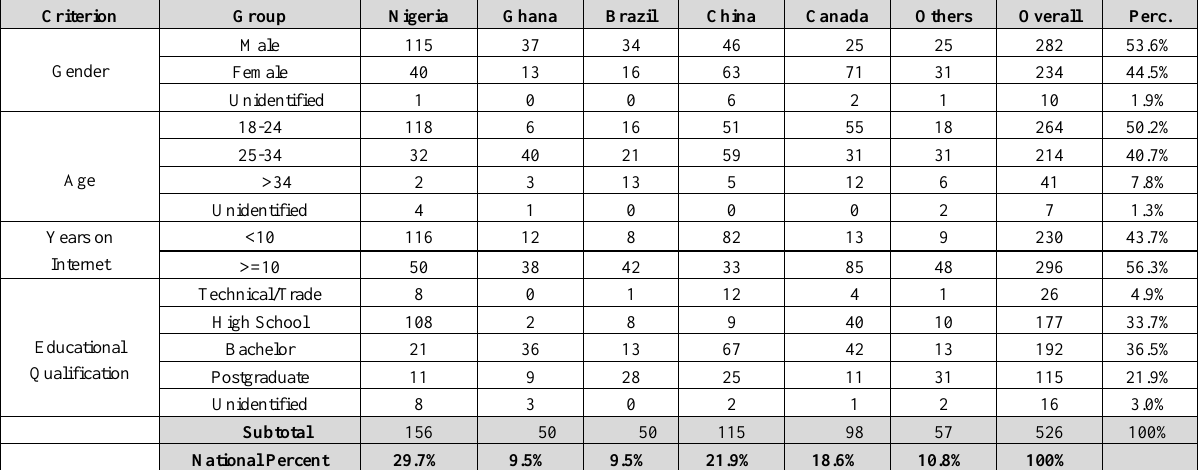
P ARTICPANTS ’ D EMOGRAPHICS ACCORDING TO COUNTRIES